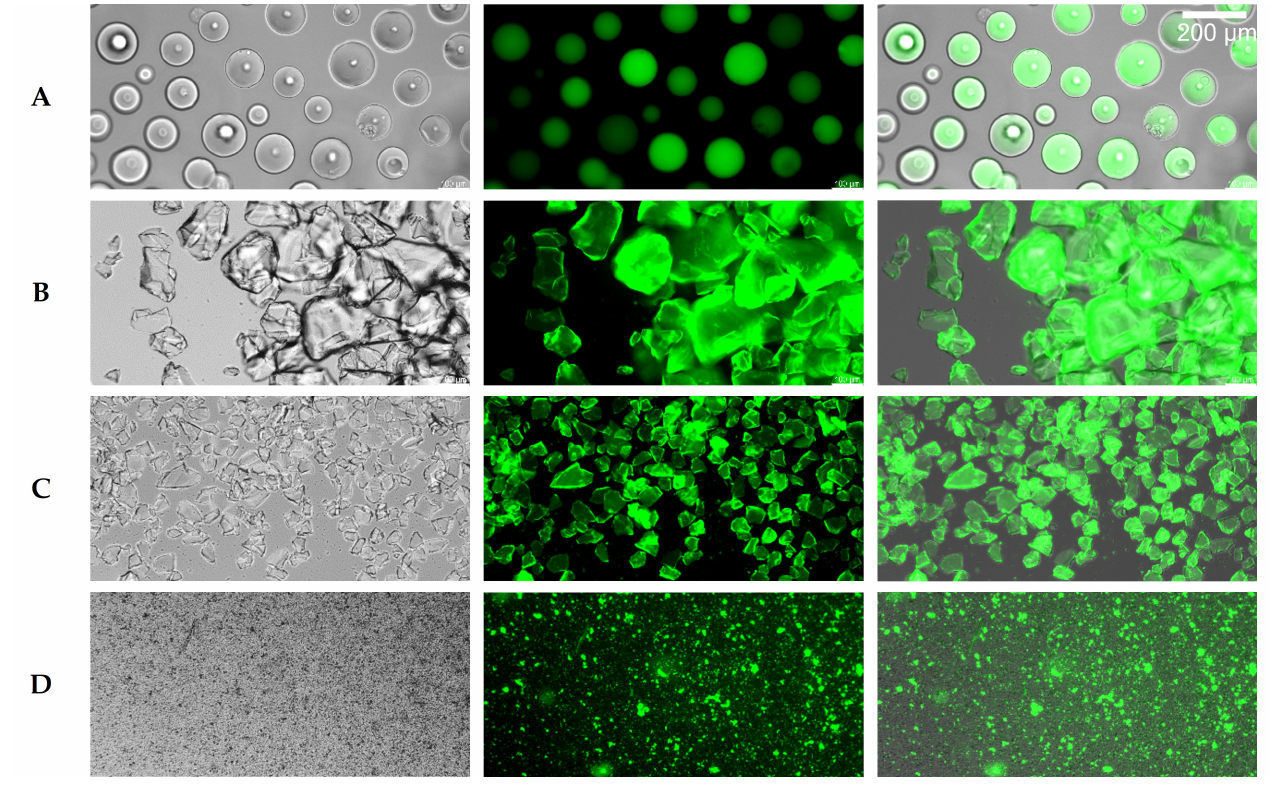
Figure 6. Microscope images of the immobilized hydrolase mutant 36P5. ( A ) Ni-NTA material; ( B ) silicic acid; ( C ) silica gel; ( D ) grinded sand. The figure shows the bright field (left), fluorescence (center) and superimposed images